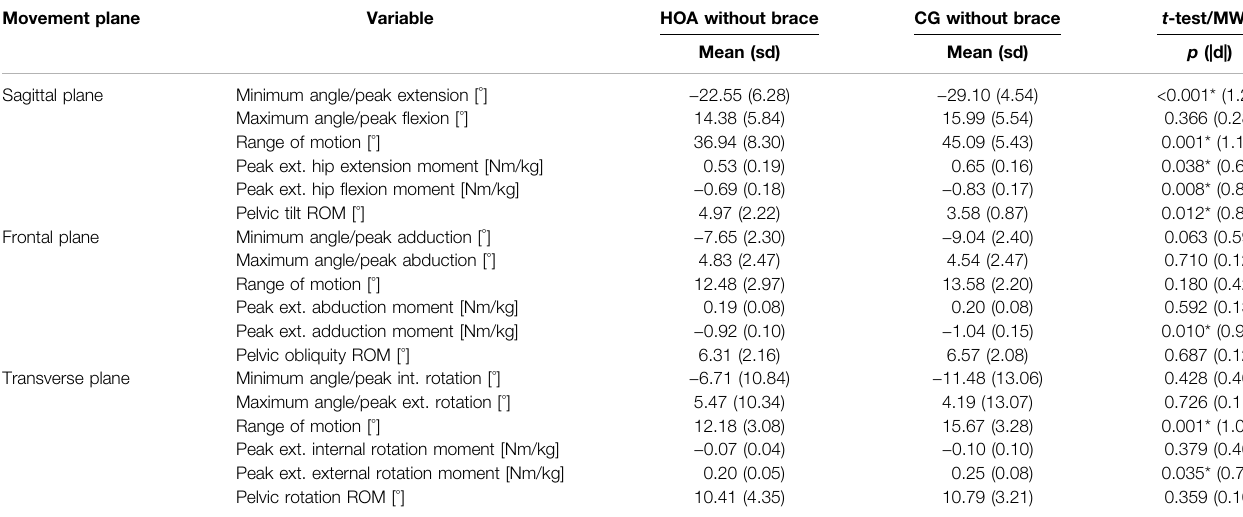
TABLE 3 | Mean values and standard deviations (sd) of discrete hip and pelvis joint angles and hip joint moment gait parameters for the hip osteoarthritis (HOA) and control group(CG)withrespective p -valuesandeffectsizes(Cohen ’ sd)asrevealedbyindependentsamplet-tests/Mann-Whitney-Utests(MWU).Levelofsigni fi cance ≤ 0.05;* marks a signi fi cant